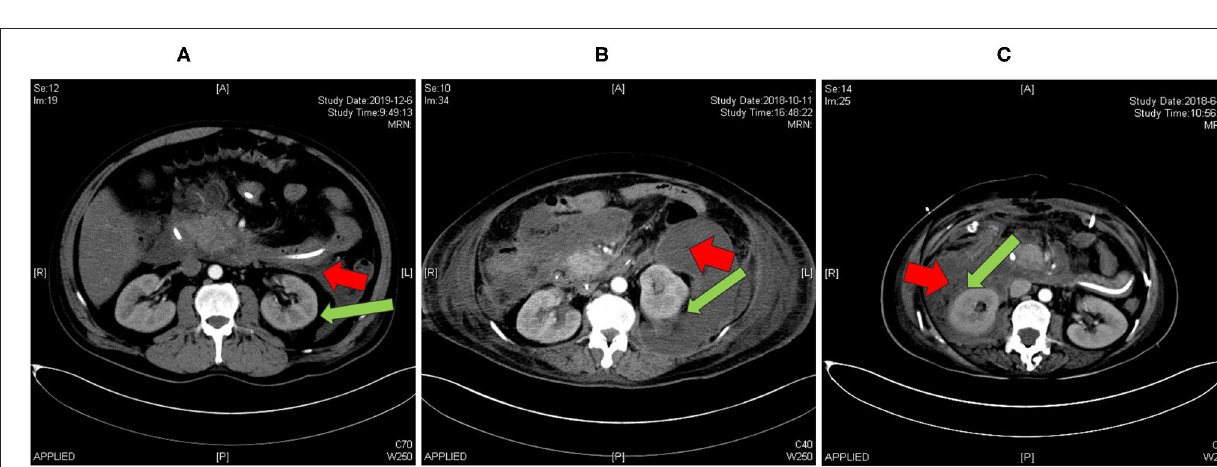
Frontiers in Medicine | www.frontiersin.org